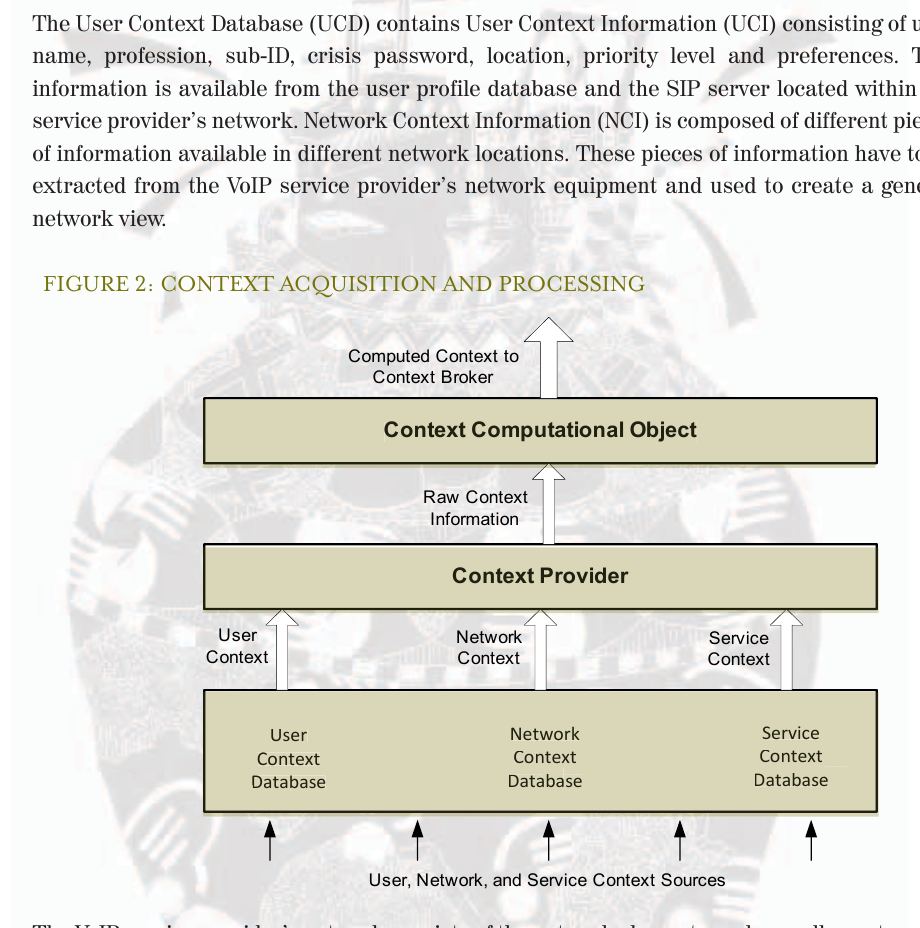
FIGURE 2: CONTEXT ACQUISITION AND